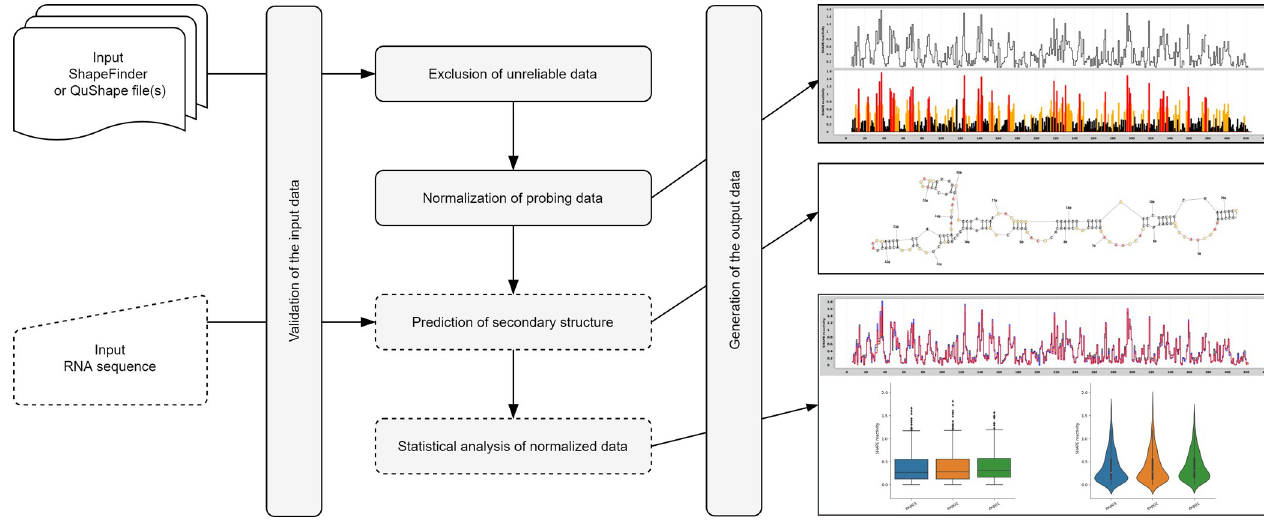
Fig 1. Workflow in the RNAthor